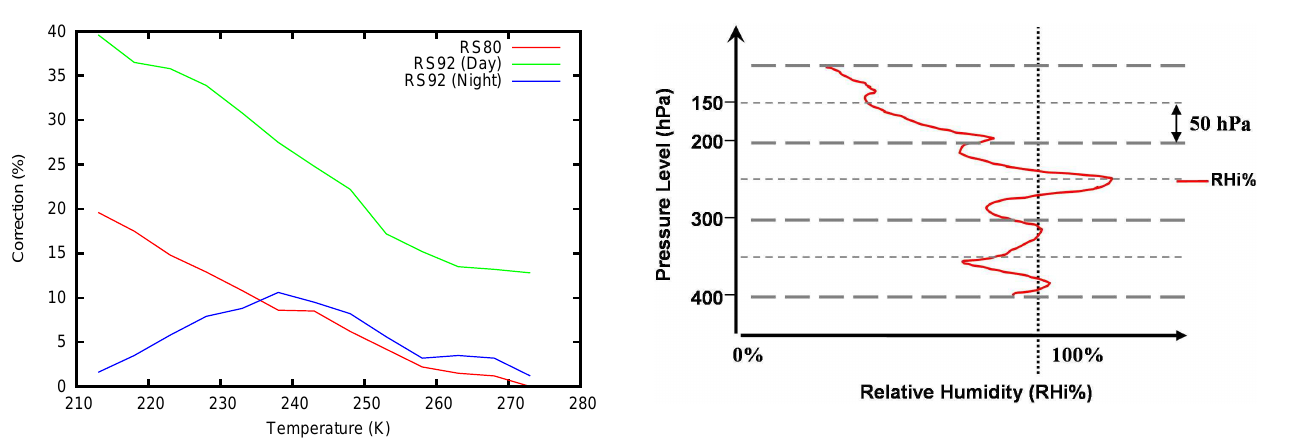
Fig. 2. The average correction made to the RS80-H and RS92 radiosonde relative humidity observations. In this case observations were corrected using Wang et al. (2002) for the RS80-H and V¨omel et al. (2007) for the RS92.